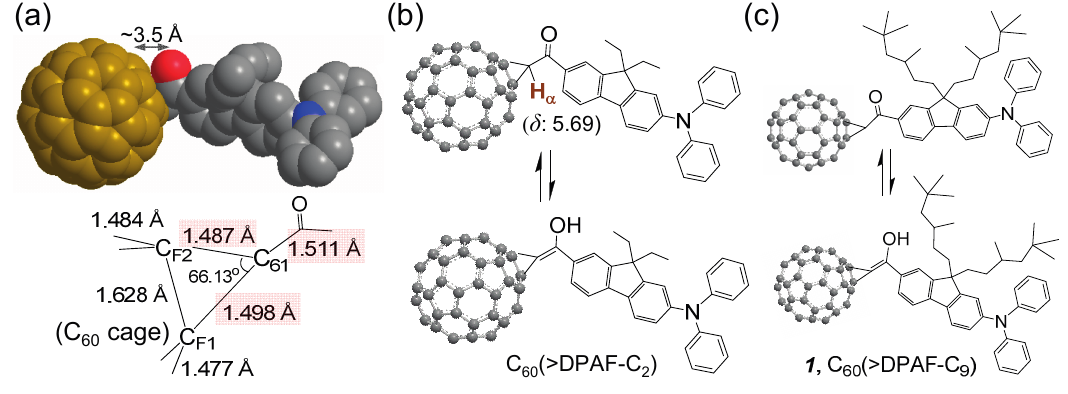
Figure 1. Bridging structure of a C 60 -DPAF-C 2 conjugate with ( a ) carbon-carbon